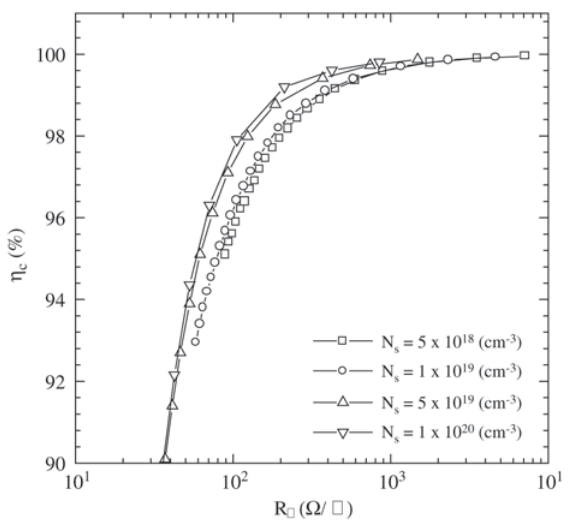
Figure 5. Emitter collection efficiency, η sheet resistivity, R passivated